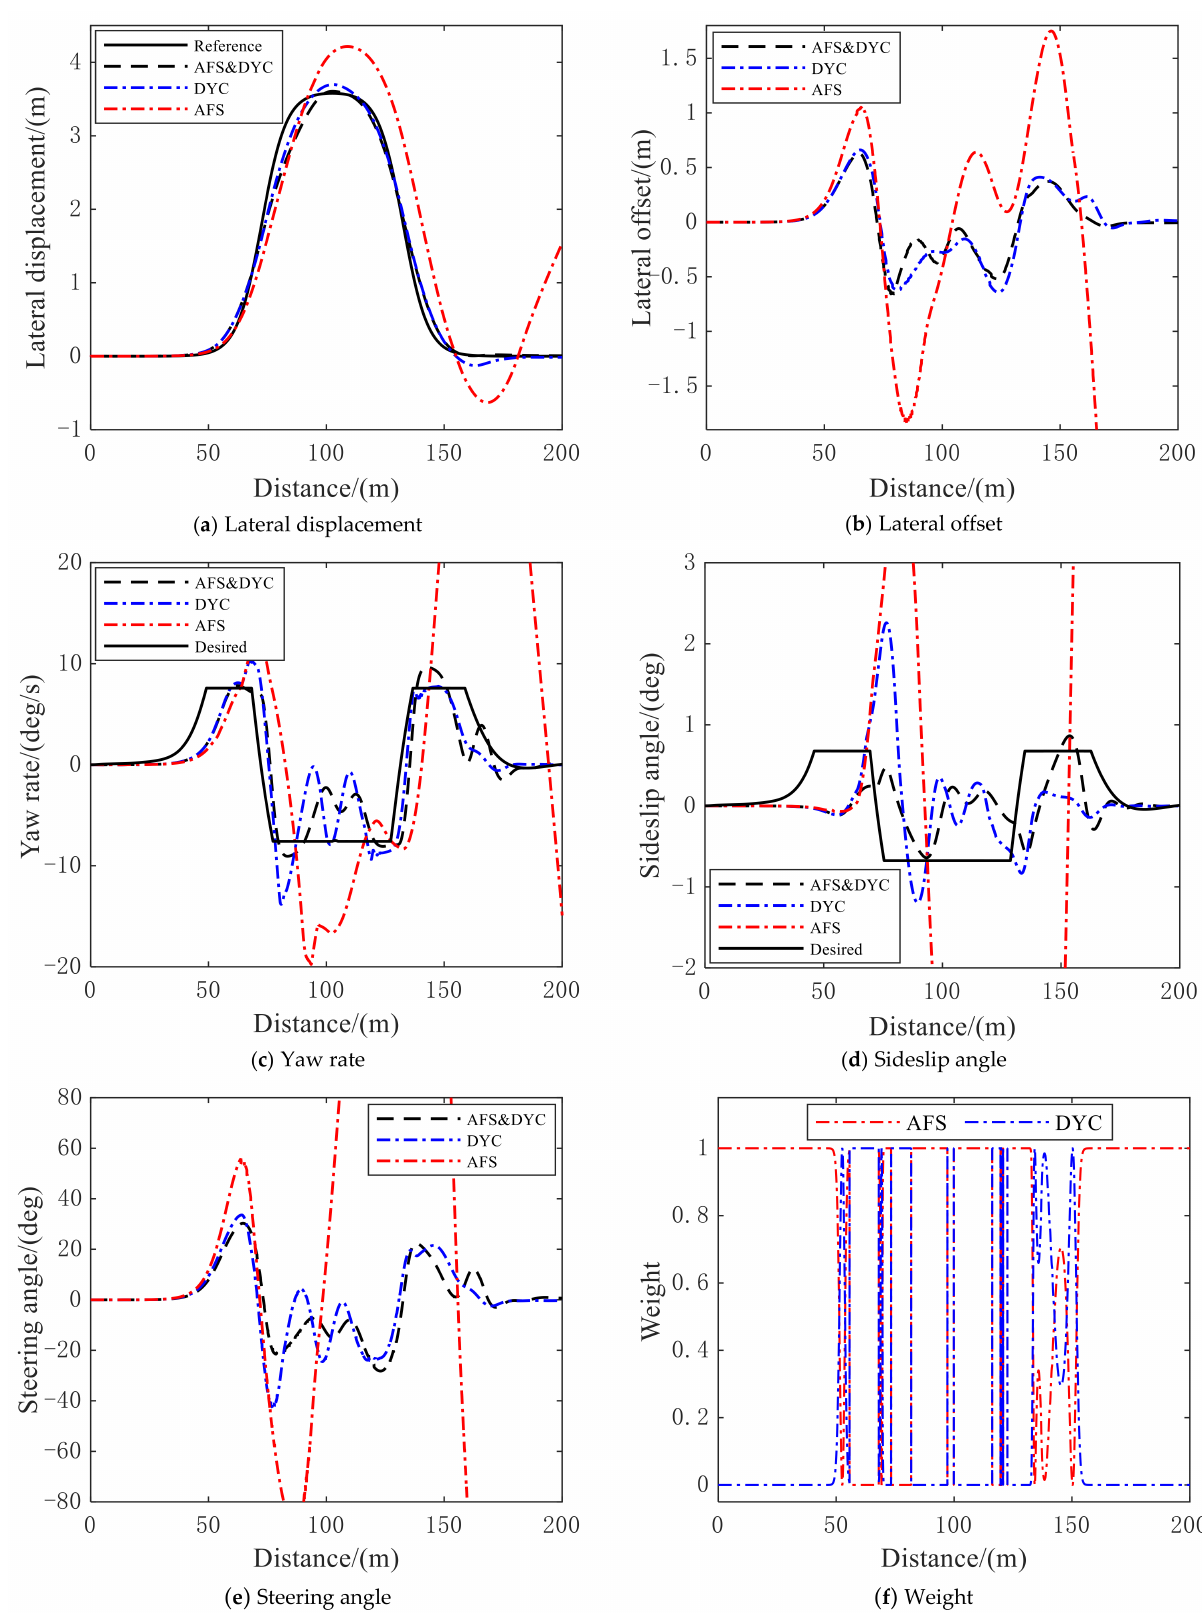
Figure 13. Performance under low adhesion coefficient: ( a ) lateral displacement; ( b ) lateral offset; ( c ) yaw rate; ( d ) sideslip angle; ( e ) steering angle; ( f ) weight of AFS and